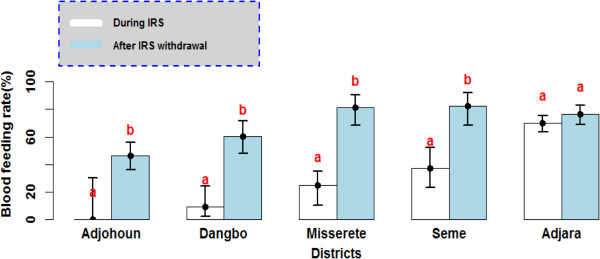
Blood feeding rate of Anopheles gambiae observed during IRS implementation and after IRS withdrawal. The rate carrying the same letter per district was not significantly different (p> 0.05).